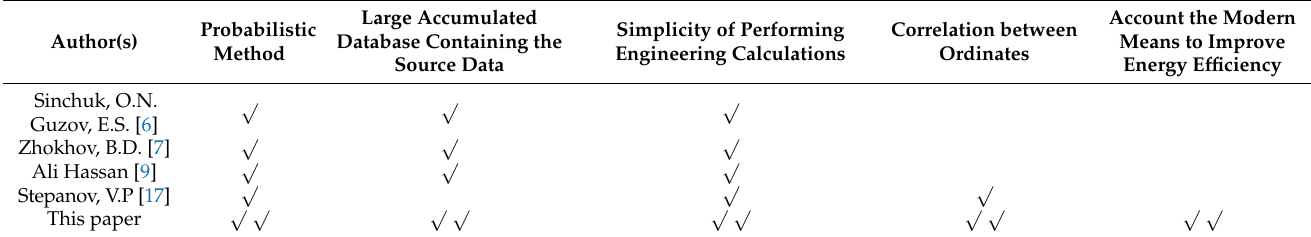
Table 1. Contributions of authors.